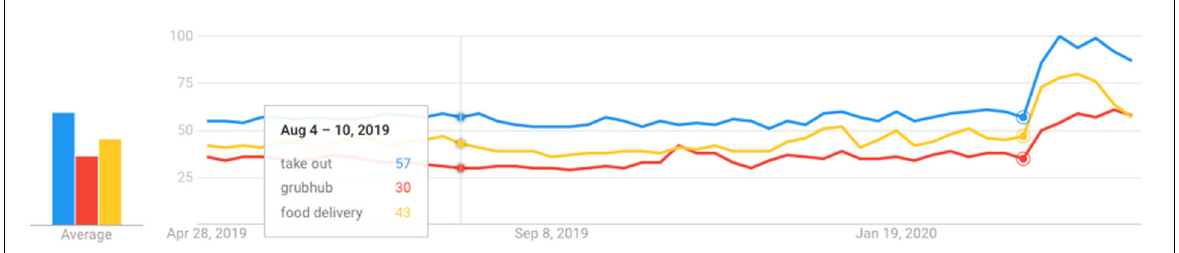
Figure 3a. Switching to Options Outside Restaurants (and Stores)